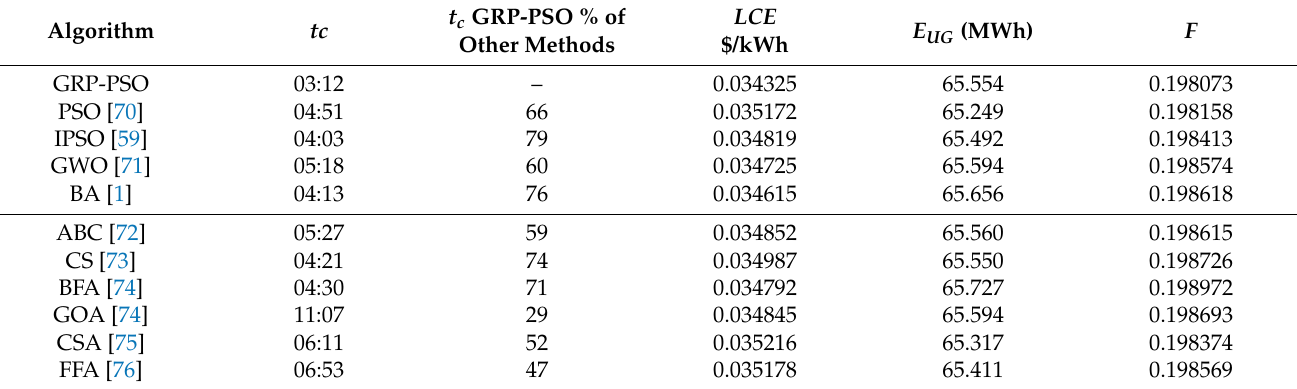
Figure 11. The fitness function against the convergence time for all optimization algorithms under- study. Table 4. The convergence performance of different optimization algorithms under